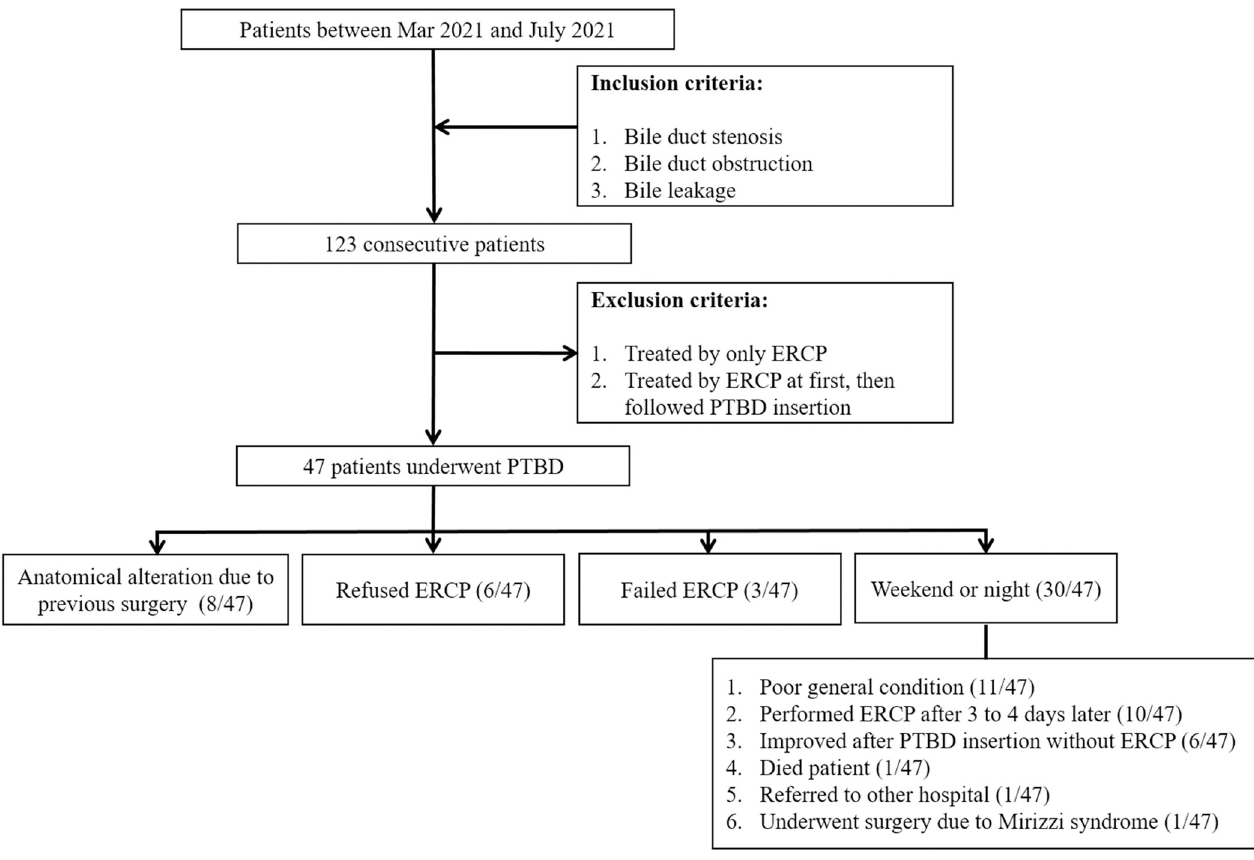
Fig 1. Flow chart of the case accrual process. laboratory examination (aspartate transaminase (AST), alanine transaminase (ALT), gamma- glutamyl transferase ( γ -GTP), bilirubin, white blood cell count, C-reactive protein) and reason